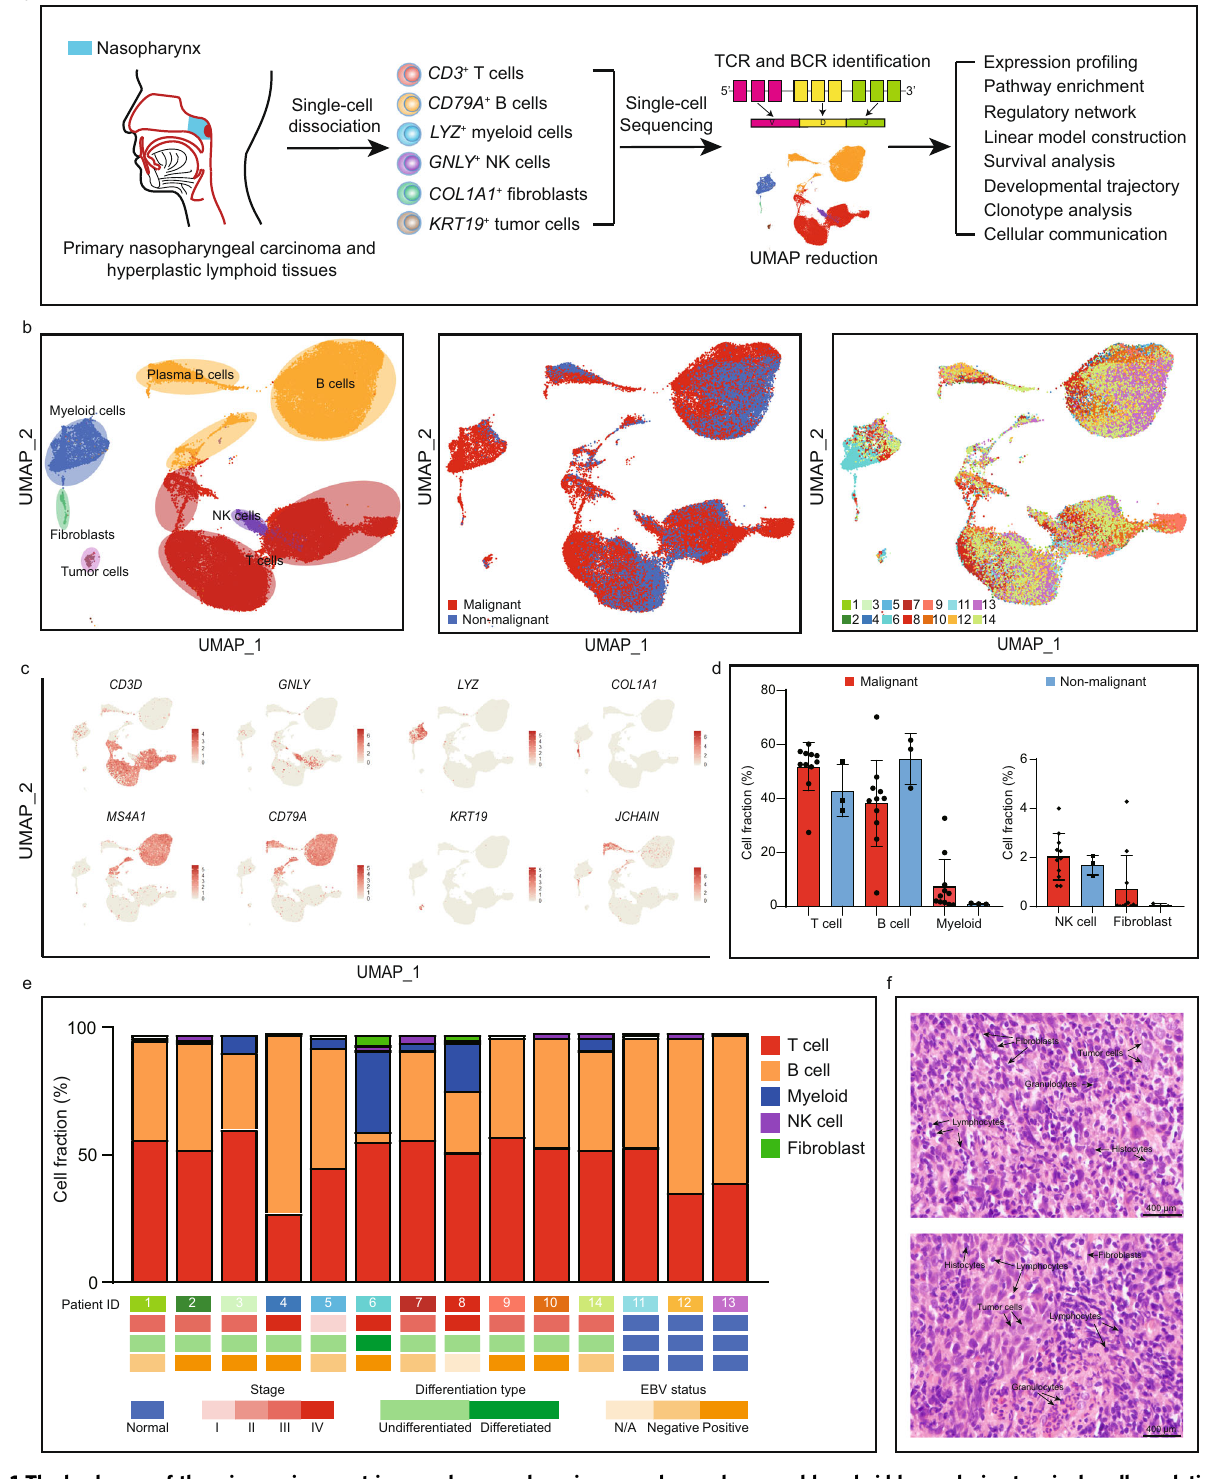
Fig. 1 The landscape of the microenvironment in nasopharyngeal carcinoma and nasopharyngeal lymphoid hyperplasia at a single-cell resolution. a Graphical summary of the experimental design. Stromal cells and cancer cells from the NPC and NLH patients were collected and processed by single-cell 5 ’ RNA sequencing for transcriptomics analysis and coupled V(D)J sequencing for clonal pro fi ling on T and B cells. b UMAP plot of 66,627 cells showing the components in the NPC and NLH microenvironment, color-coded by the major cell lineage (left), sample type (middle) and corresponding patient (right). c The expression of marker genes for the major lineages de fi ned in a . d The relative abundance of the major cell lineages in the malignant ( n = 11 biologically independent samples) and non-malignant ( n = 3 biologically independent samples) microenvironment. Data are presented as mean values ± SD. e The fraction of major cell lineages originating from the 14 patients, with their clinical information. Source data are provided as a Source Data fi le. f The representative H&E staining images (400×) taken from two NPC patients, showing the high stromal in fi ltration in the NPC microenvironment. Scale bar = 400 µ